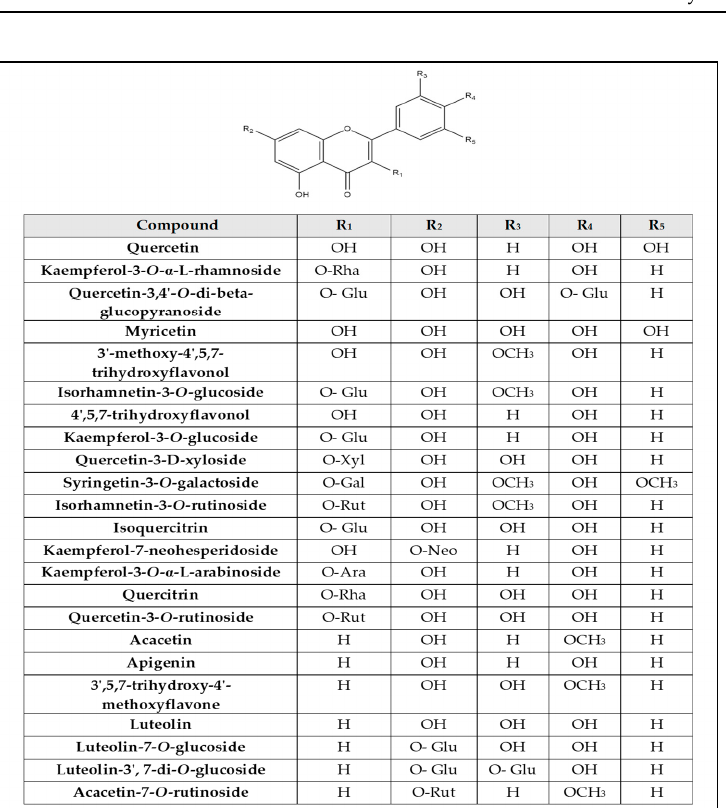
Figure 1. Structures of flavones, flavones glycosides, flavonols, and flavonols glycosides (Glu = glucoside, Gal = galactoside, Rha = rhamnose, Ara = arabinose, Xyl = xylose, Neo = neohesperidoside, Rut = rutinoside).